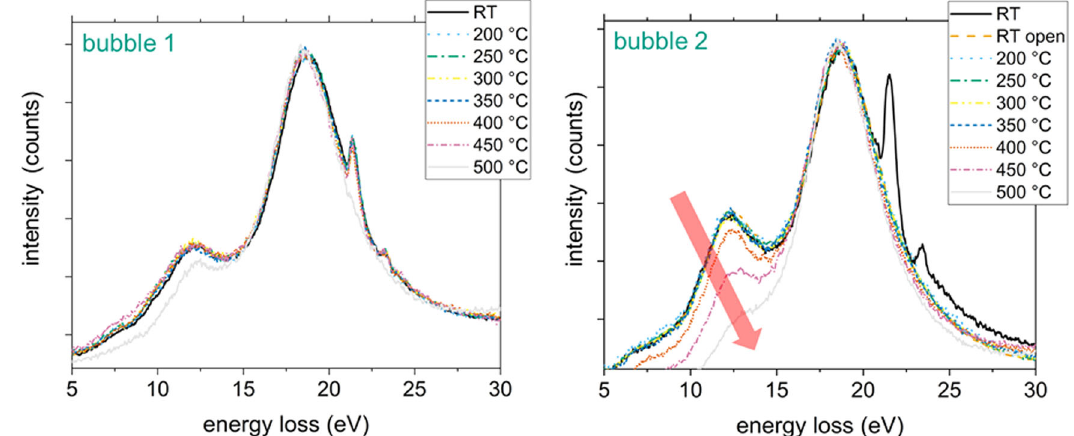
Fig. 4 In situ EELS measurements of bubbles. EEL spectra obtained from a closed (bubble 1) and an opened bubble (bubble 2) at room temperature and during stepwise heating. While the hydrogen peak in the closed bubble does not show a signi fi cant change during heating, the hydrogen signal vanishes with increasing temperature for the opened